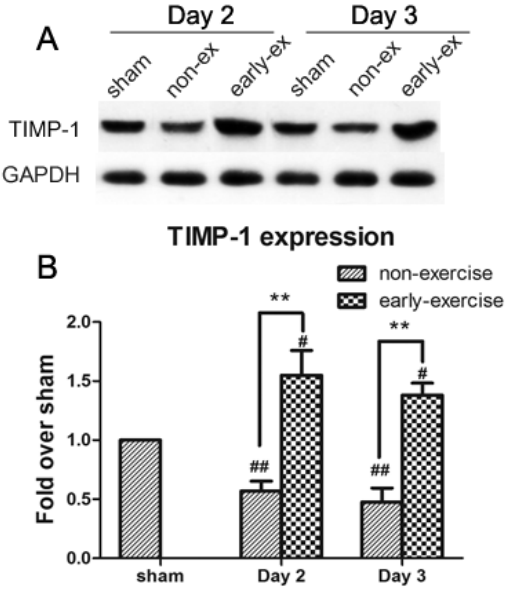
Figure 7. Effect of early exercise on the expression of TIMP-1 protein following focal cerebral ischemia. ( A ) Representative bands of TIMP-1 expression in ischemic brains following MCAO detected by Western blotting; ( B ) Quantification of the optical density of the TIMP-1 bands, normalized to GAPDH. The low TIMP-1 levels induced by MCAO were increased by early exercise. ** p < 0.01, compared with the NE group; # p < 0.05 and ## p < 0.01, compared with the sham group. n = 6.